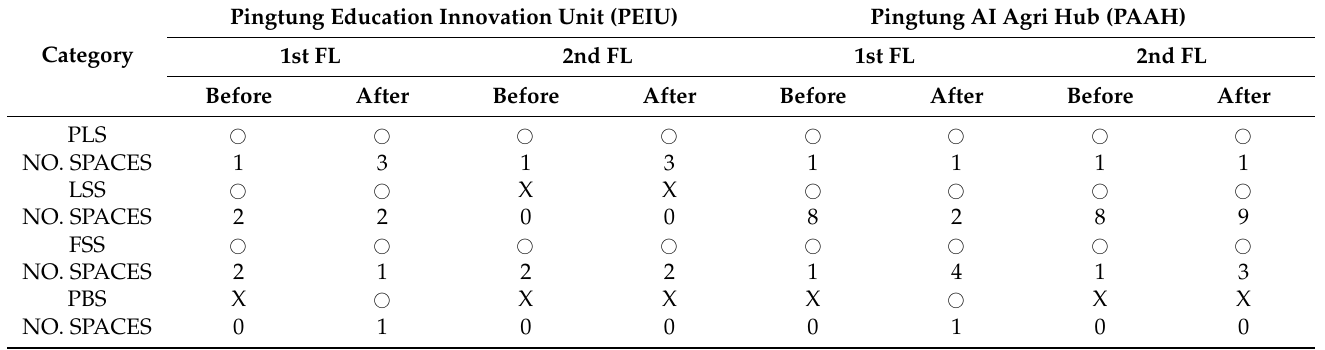
Table 4. Transformation Analysis of Territory